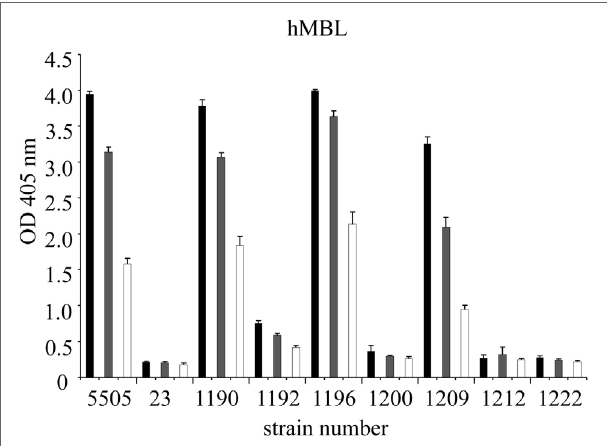
FigUre 4 | Recognition of selected Hafnia alvei lipopolysaccharides (LPSs) by human MBL. Microtiter plates were coated with LPS, incubated with NHS to measure interactions with hMBL. Black, gray, and white bars represent 200-, 400-, and 800-fold dilutions, respectively. Data represent the mean values of four replicates and are marked by PCM strain number. Strain 5505 represents Klebsiella pneumoniae O3:K55 − LPS used as a positive control. Abbreviations: OD, optical density measured at λ = 405 nm; hMBL, human MBL; NHS, normal human serum; PCM, Polish Collection of Microorganisms.